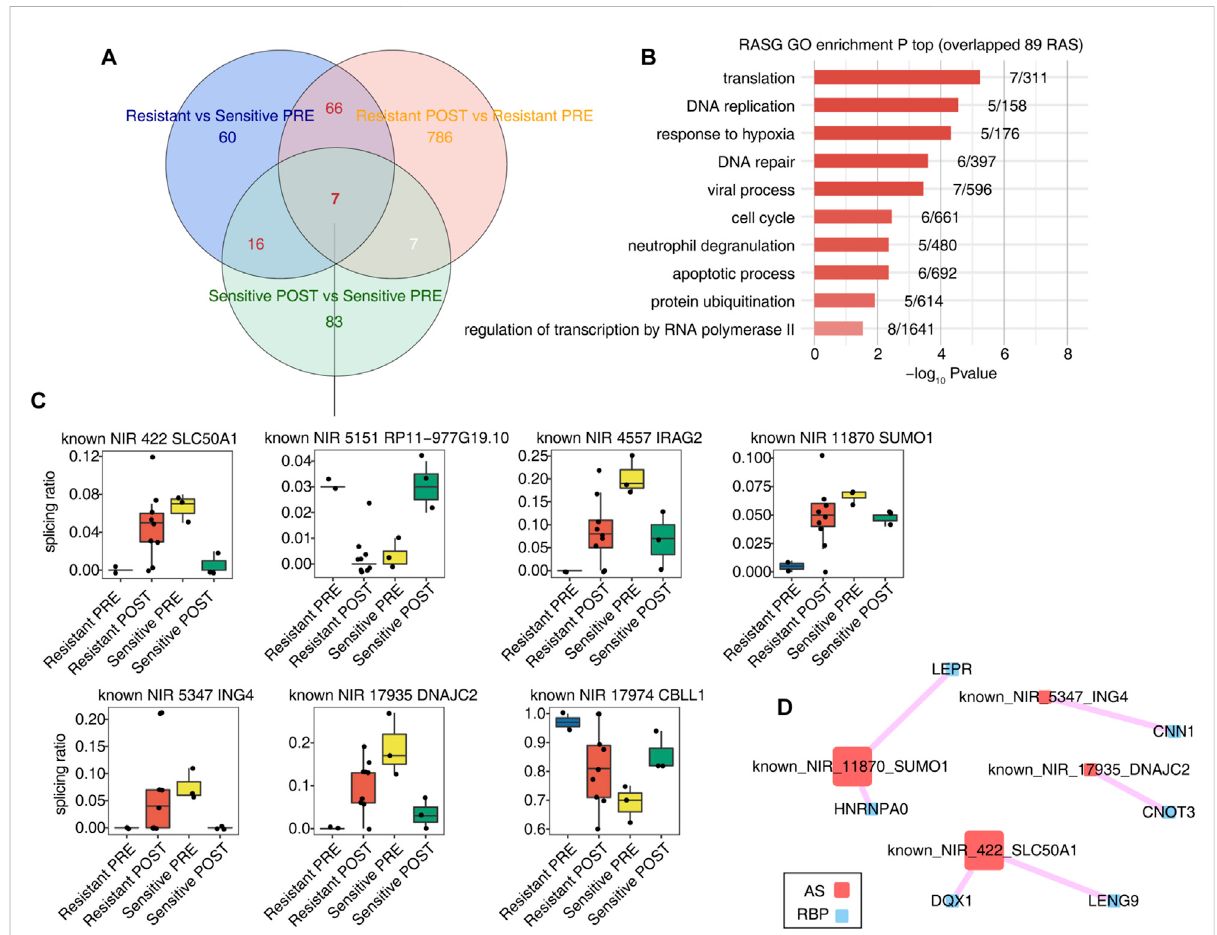
afterHDACitreatment. (A) VenndiagramshowingtheoverlapofRASbetweenResistantPREandSensitivePREsamples,RASbetweenResistantPOST and Resistant PRE samples, and RAS between Sensitive POST and Sensitive PRE samples. (B) Bar plot showing the most enriched GO biological process results of genes of 89 RAS with red lable in (A) (C) The co-disturbed network between expression of RBPs and splicing ratio of RASEs involved in Figure 3C was constructed. Pearson ’ s correlation| ≥ 0.7 and pvalue ≤ 0.01 were retained. Circles represent RBP genes. Squares indicate